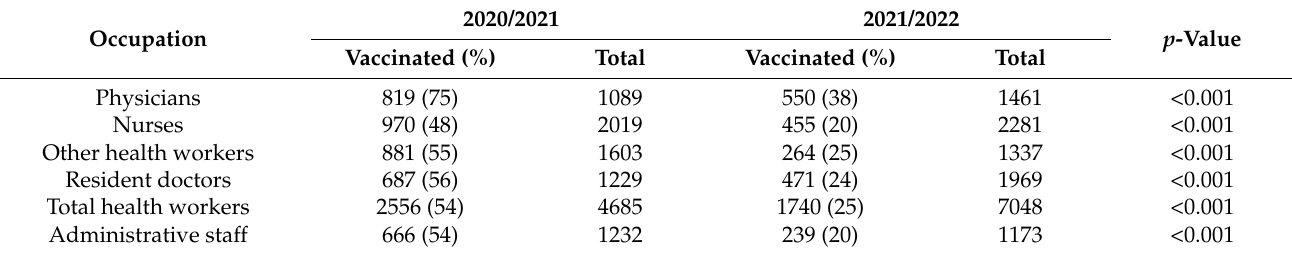
Table 1. Vaccination coverage by occupation in the last two years.